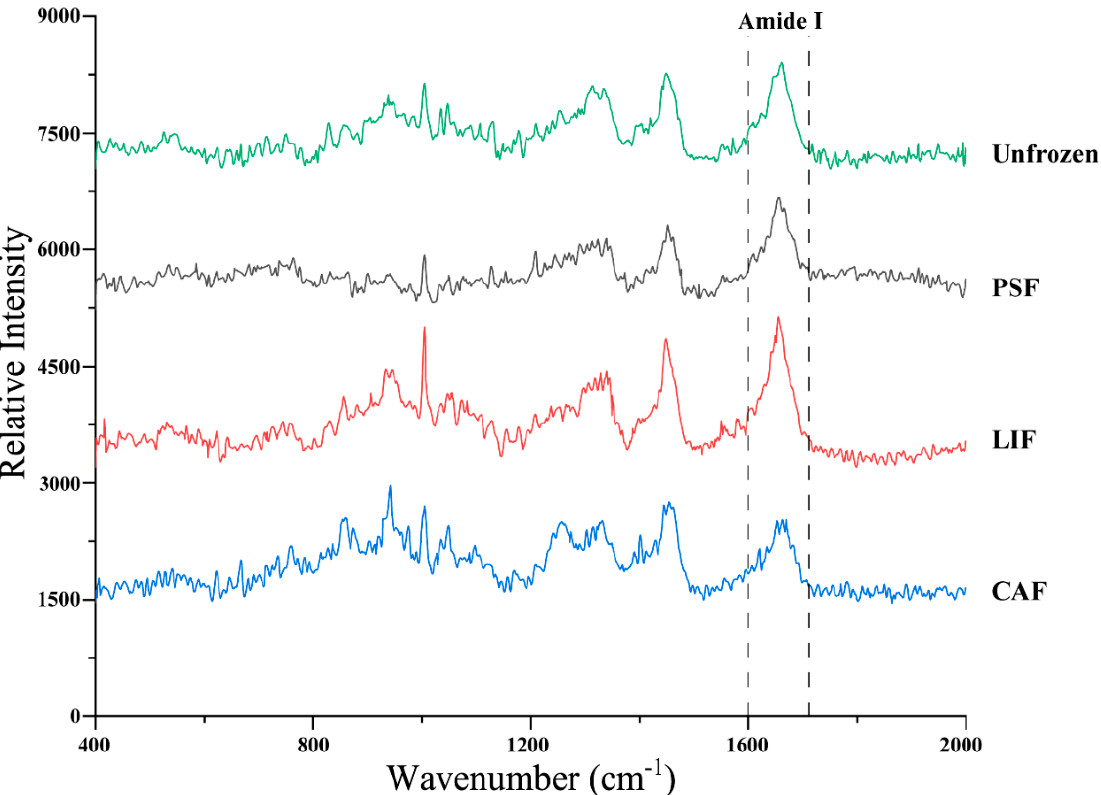
Figure 4. Raman spectra of largemouth bass proteins from unfrozen fish and fish frozen under different freezing methods stored for 28 days in the 400–2000 cm − 1 region. Acronyms: PSF = Pressure − shift freezing; LIF = Liquid immersion freezing; CAF = Conventional air freezing.